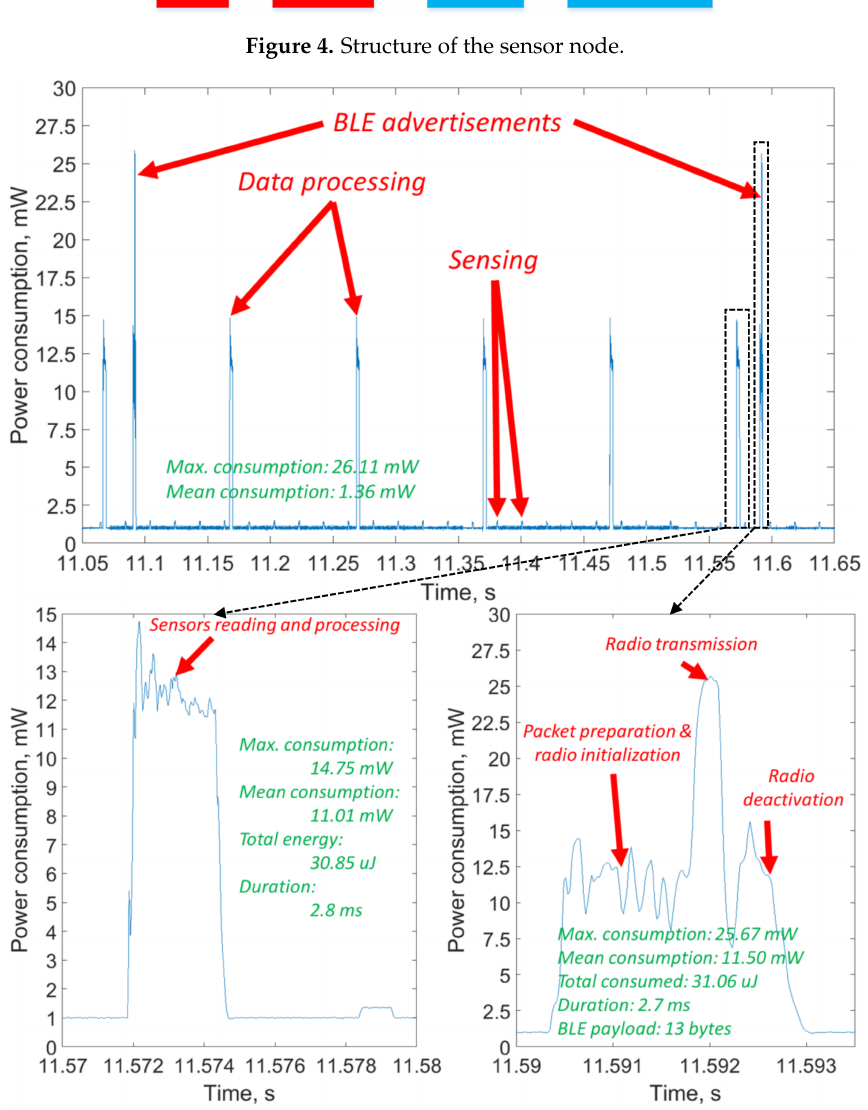
Figure 5. Measured power consumption profile of the sensor